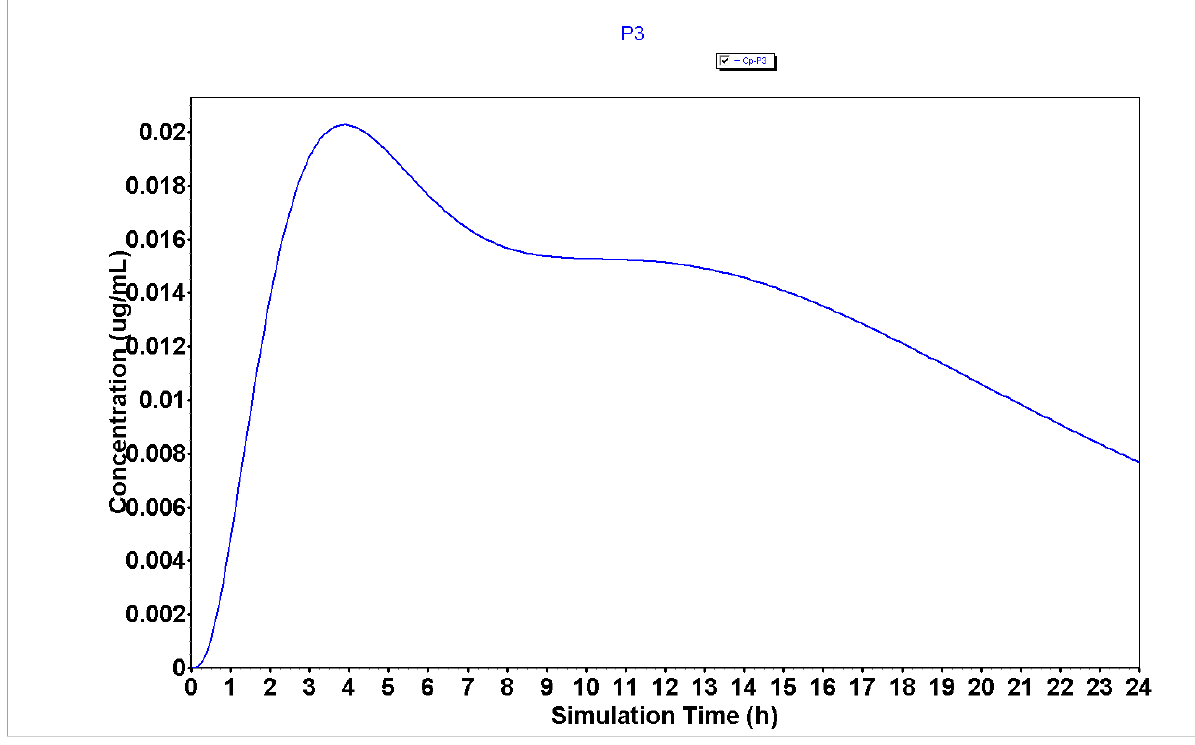
Figure 7. Plasma concentration of P3 generated using the GastroPlus ® software.